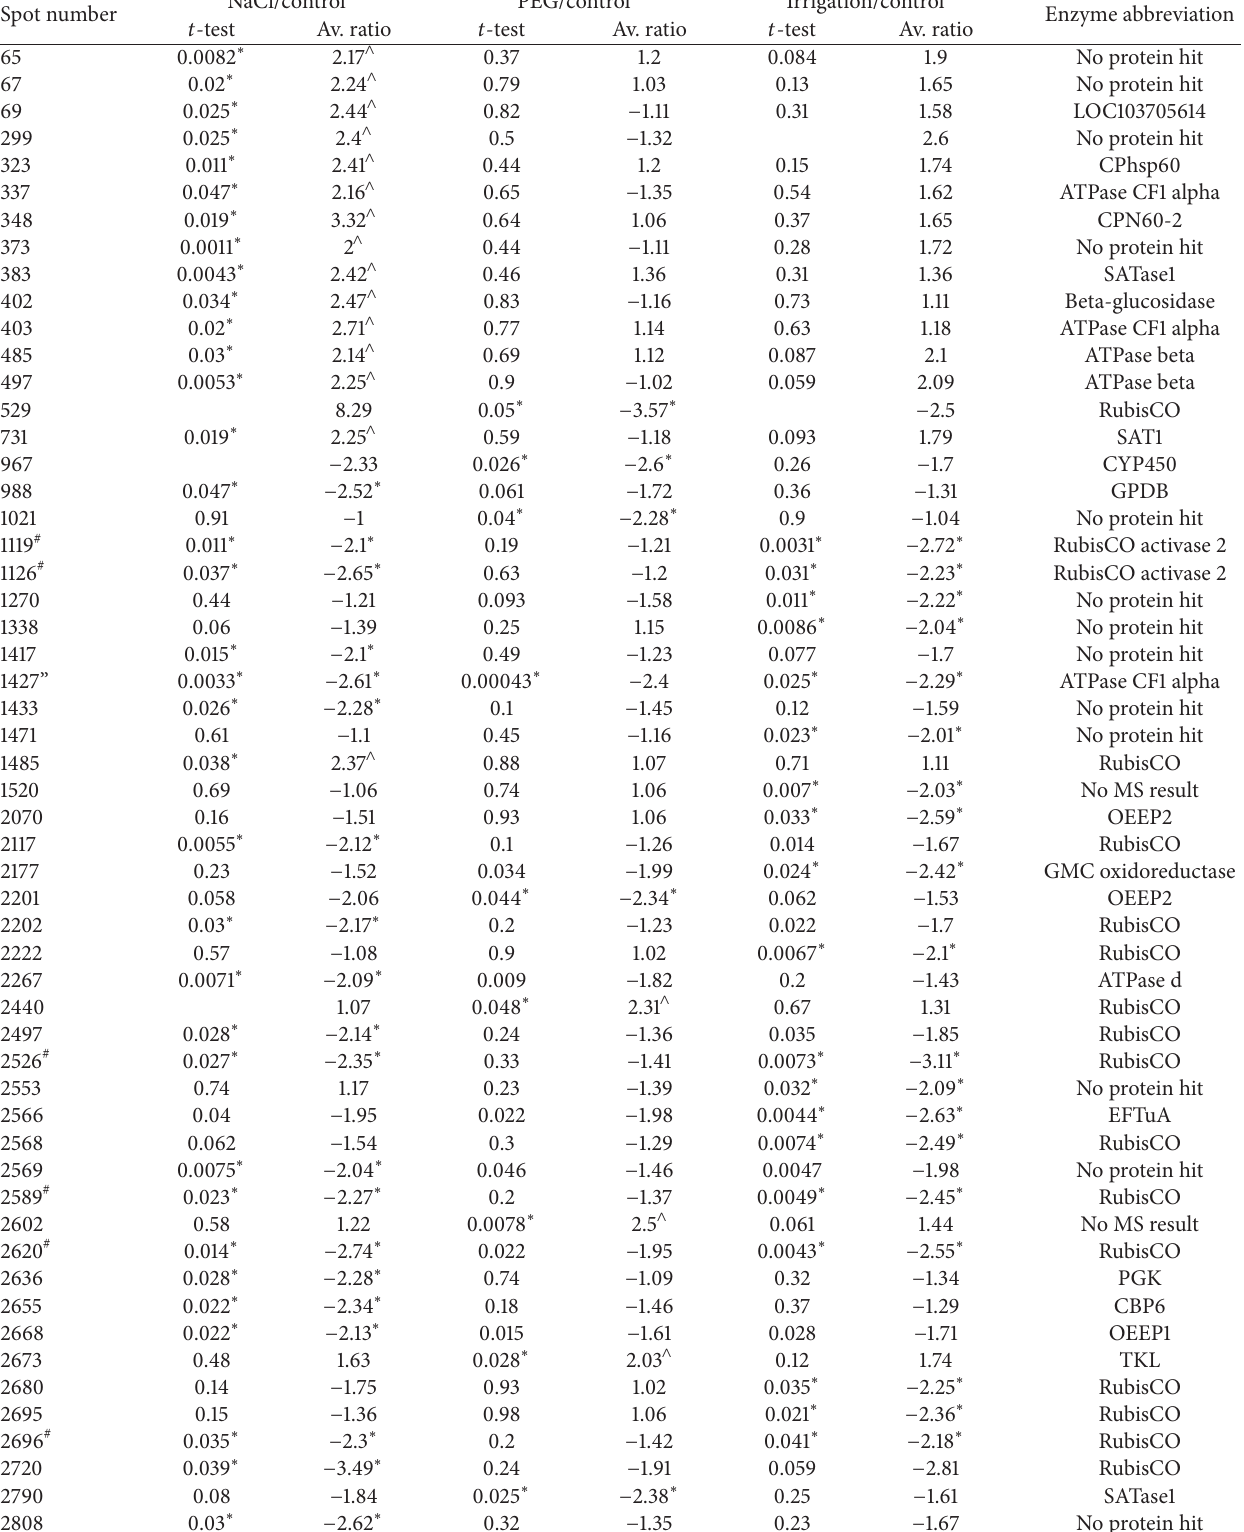
Table 2: DIGE results: overview of the significantly changed spots and their behavior in other studied